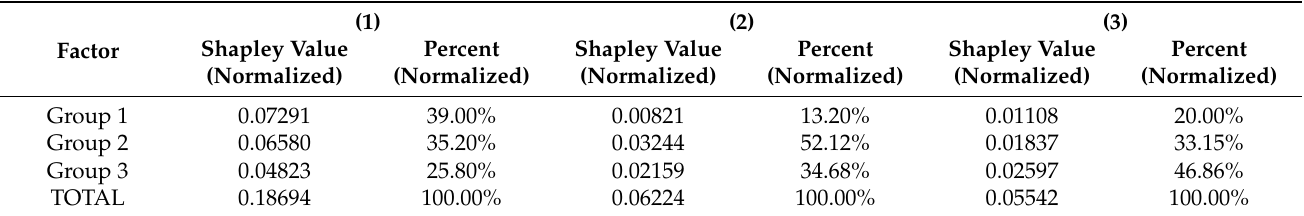
Table 4. Decomposition of factors influencing grain loss based on Shapley values.